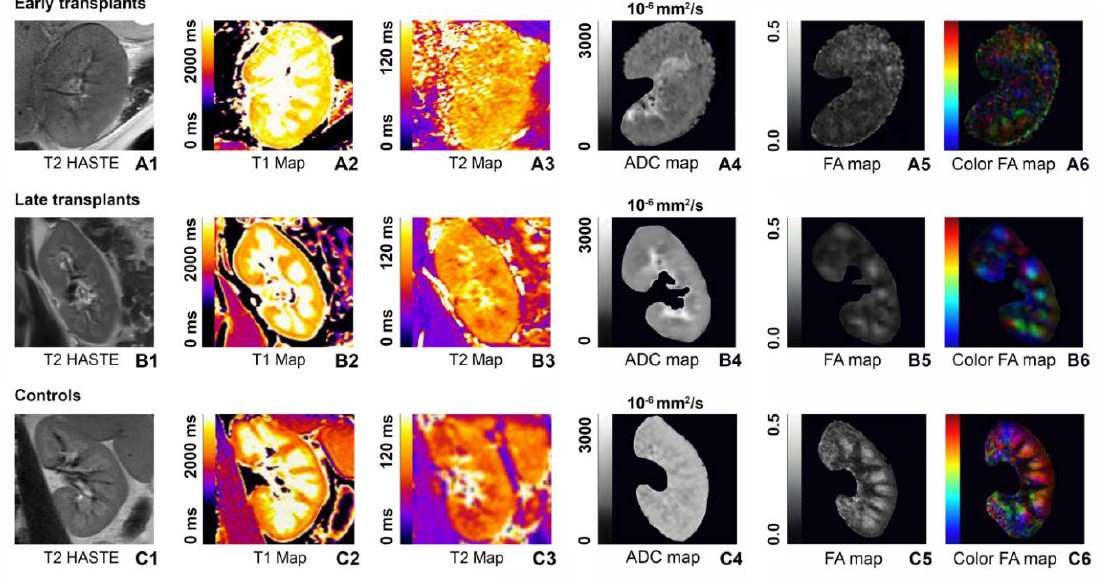
Figure 1. ( A1 – A6 ) Standard macroscopic T2-weighted sequence ( A1 ) and images of renal T1 ( A2 ) and T2 maps ( A3 ) as well as ADC ( A4 ) and FA maps ( A5 , A6 ) for an early transplant. ( B1 – B6 ) Images of a late transplant (half a year since transplantation). ( C1 – C6 ) MR images of a control with a healthy native kidney. Corresponding color bars are presented on the left side of each map, with 0–2000 ms for T1 maps, 0–120 ms for T2 maps, 0–3000 × 10 − 6 mm 2 / s for ADC maps, and 0.0–0.5 for FA maps. Generally, lighter colors / greyscales indicate higher values. As one can see from the above color-coded images, T1 and T2 relaxation times are highest in the newly transplanted kidney ( A1 – A3 ) and lowest in the healthy native kidney ( C1 – C3 ). In contrast, the ADC and especially the FA map for the newly transplanted kidney shows the lowest ADC and FA values with only moderate di ff erentiation between cortex and medulla ( A4 , A5 ), while ADC and FA values are higher for the older stable allograft ( A4 , B5 ) and highest for the healthy native kidney ( C4 , C5 ).